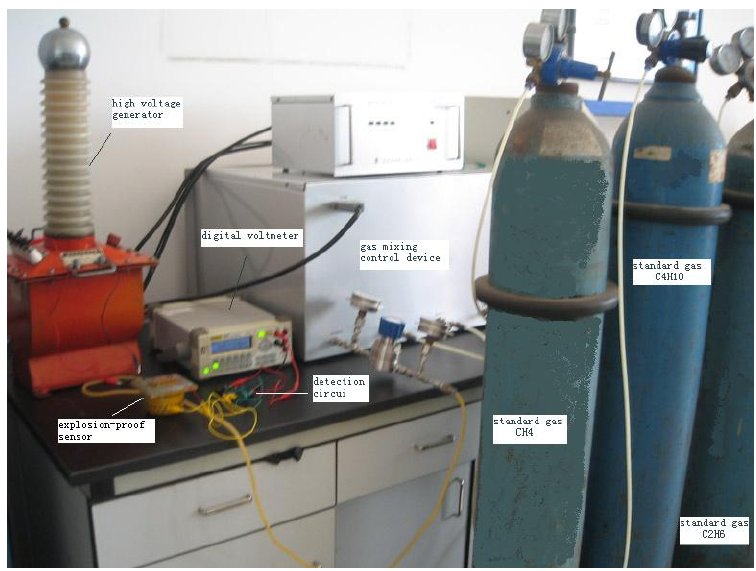
Figure 5. Experimental system for the gas